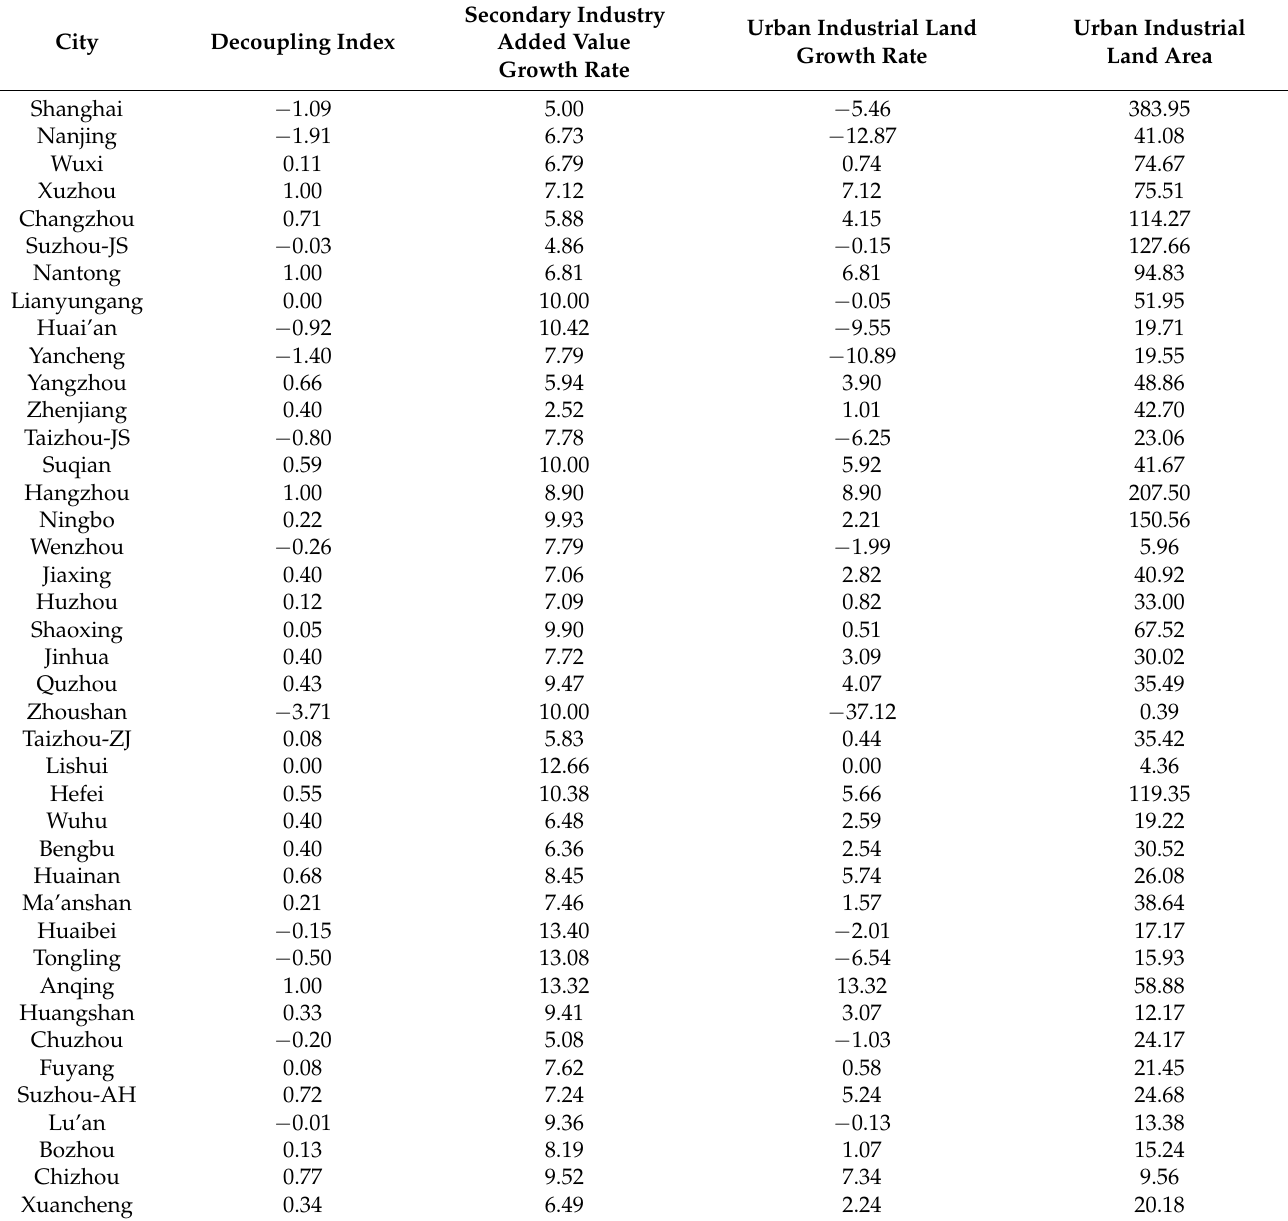
Table 9. Prediction of urban industrial land area based on the decoupling